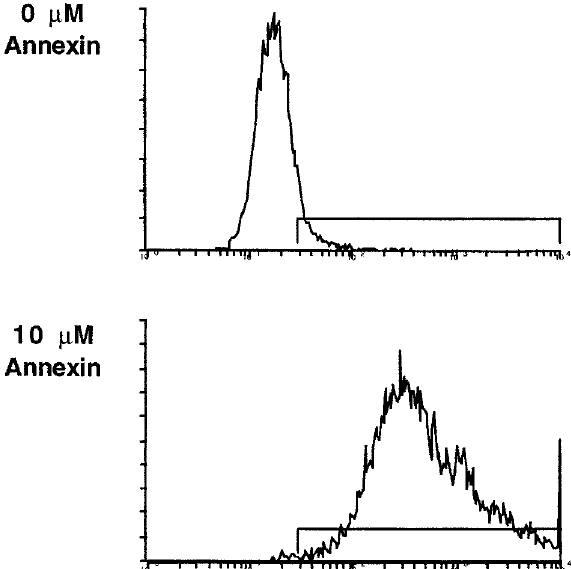
FIG. 1. Fluorescence histograms of annexin I binding sites on human FLS. FLS were incubated with rh annexin I, and annexin I binding detected by flow cytometry after labelling with an anti-annexin ImAb. Representative data obtained using (a) 0 m M and (b) 10 m M annexin I are depicted. The x -axis represents mean fluorescence intensity, and the y -axis the relative cell number. Mean data for 6 experiments are provided in Table 1.